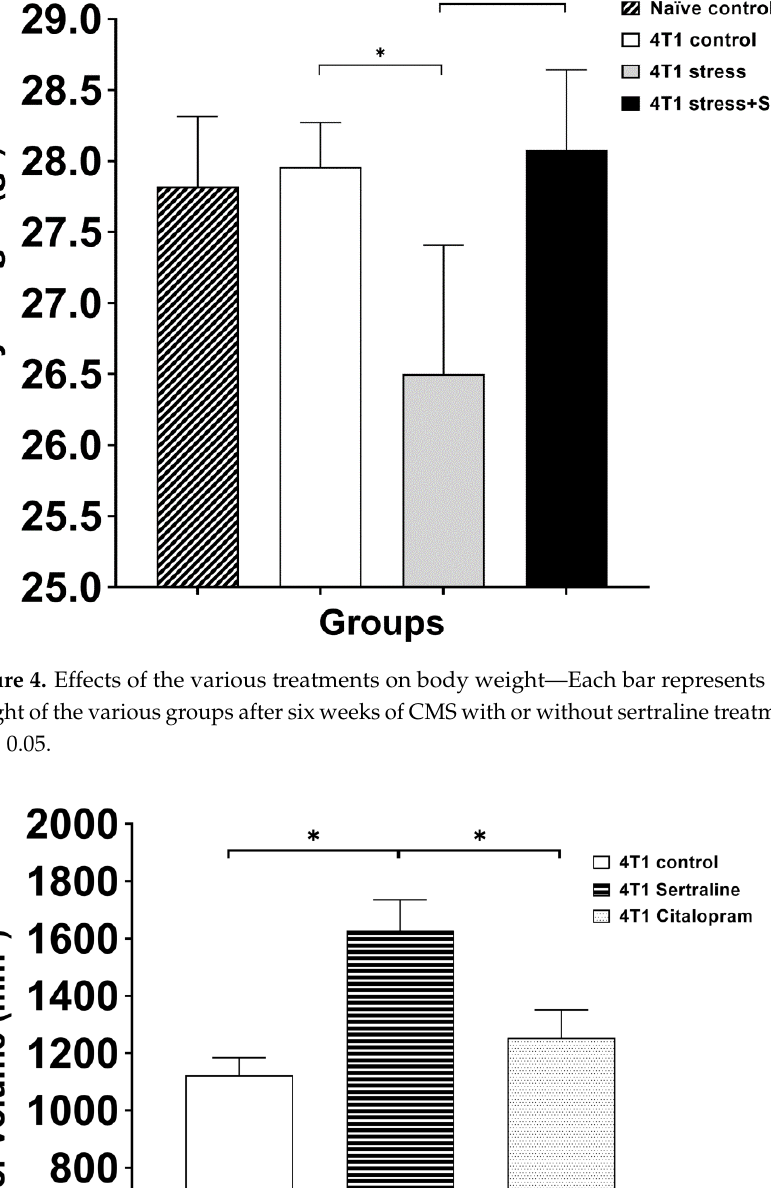
Figure 3. Behavior of 4T1cell inoculated mice in Open Field test — Effects of chronic mild stress (CMS) and sertraline treatment (5 mg/kg/d, seven days after 4T1 cell inoculation) on center zone performance in Open Field test were measured by frequency of entry into center zone, time spent in it and duration of movement in the center. Results are expressed as mean ± SE of three separate experiments, which included five mice per group. * p < 0.05.